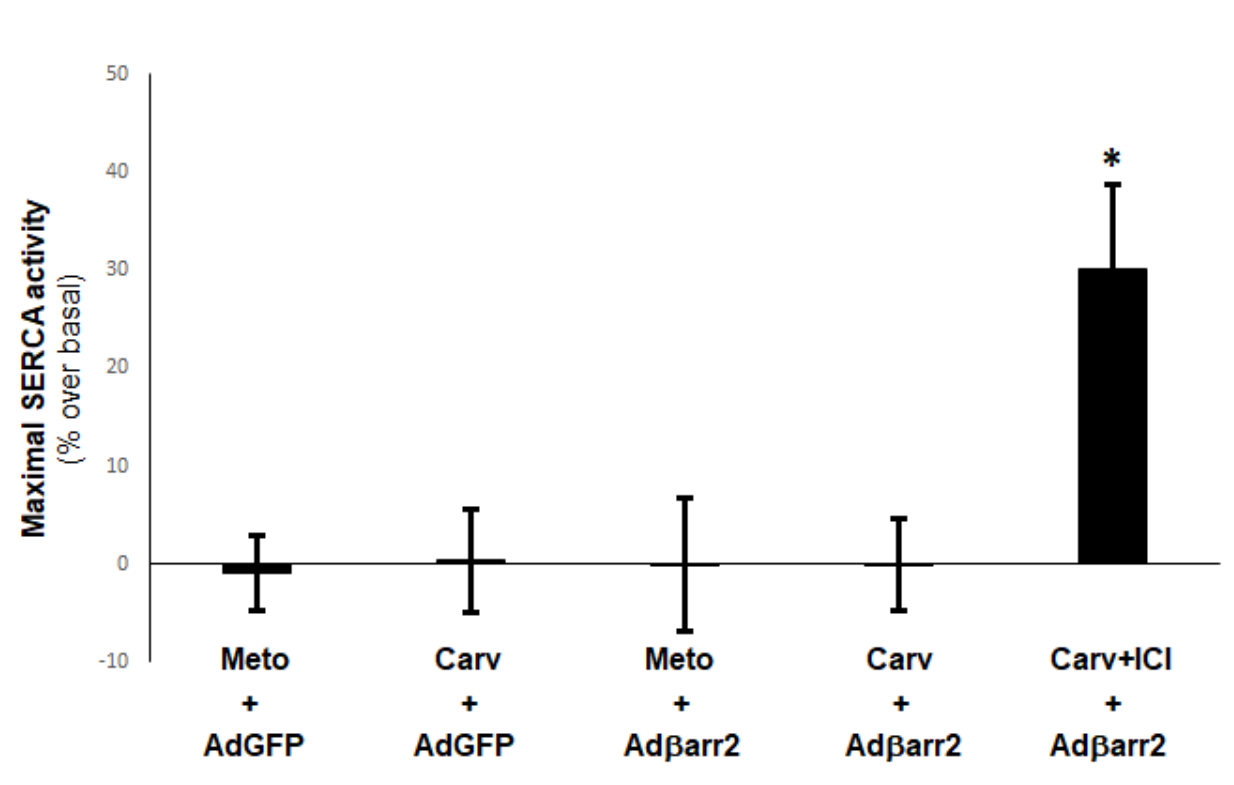
Figure 2. β -blockers and SERCA2a activity in β arrestin2-overexpessing H9c2 cardiomyocytes. Maximal SERCA activity in microsomes isolated from β arrestin2-expressing (Ad β arr2) or control (AdGFP) H9c2 cardiomyocytes and treated with 1 μM metoprolol (Meto), 1 μM carvedilol (Carv), or 1 μM carvedilol in the presence of 10 μM ICI 118,551 (Carv + ICI) for 30 min. * , p < 0.05, vs. any other group; n = 3 independent measurements/transfection group/treatment.